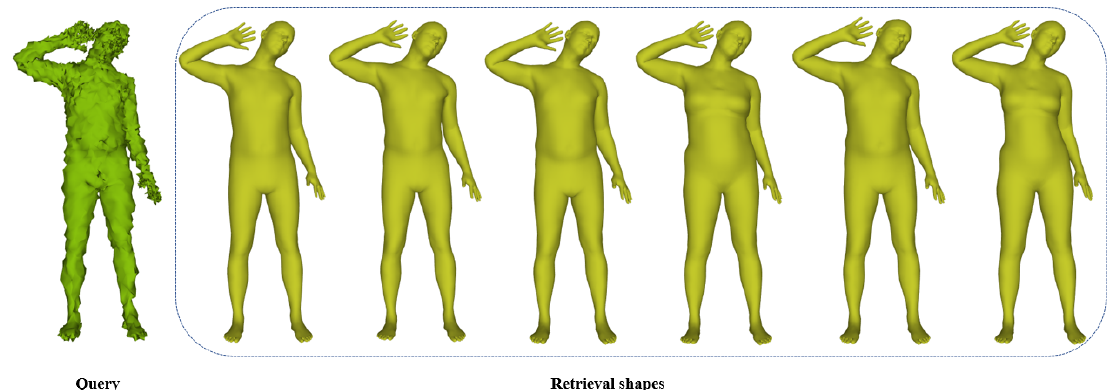
Figure 16. Given a noisy query shape, the proposed pose retrieval method is still